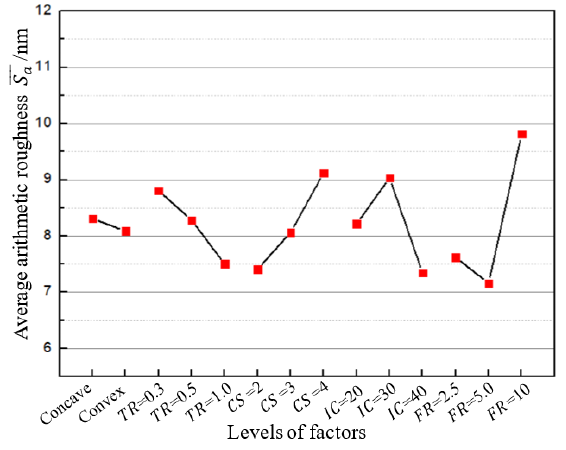
Figure 7. Average arithmetic roughness S a of four slope degrees under various levels for each factor.